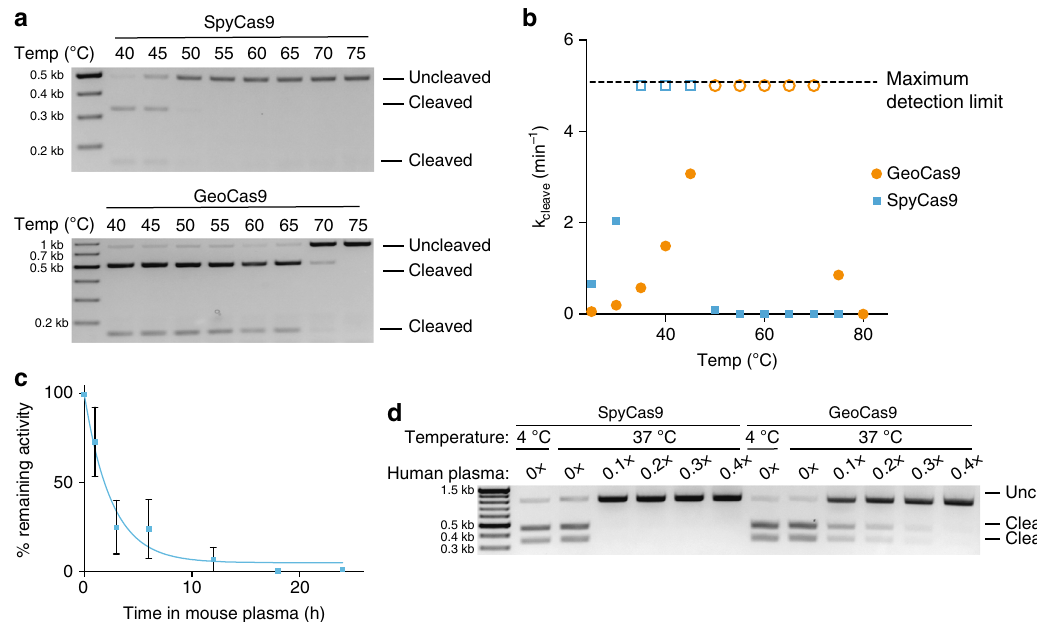
Fig. 5 Thermostability of GeoCas9 and longevity in human plasma. a Activity of SpyCas9 and GeoCas9 after incubation at the indicated temperature. After challenging at the higher temperature, reactions were conducted at 37 °C using a 1:1 ratio of substrate to RNP. b Cleavage rate of SpyCas9 and GeoCas9 RNPs at various temperatures. Maximum detection limit is shown by the dashed line at k cleave = 5, indicating that the reaction completed in ≤ 30 s. c Lifetime of SpyCas9 after incubation in 50% mouse plasma. Incubation was done at 37 °C for the speci fi ed amount of time after which DNA substrate was introduced at an equimolar ratio of substrate to RNP. d Effect of incubating GeoCas9 and SpyCas9 in human plasma. After incubation in varying concentrations of human plasma for 8 h at 37 °C, the reaction was carried out with 1:1 ratio of DNA substrate to